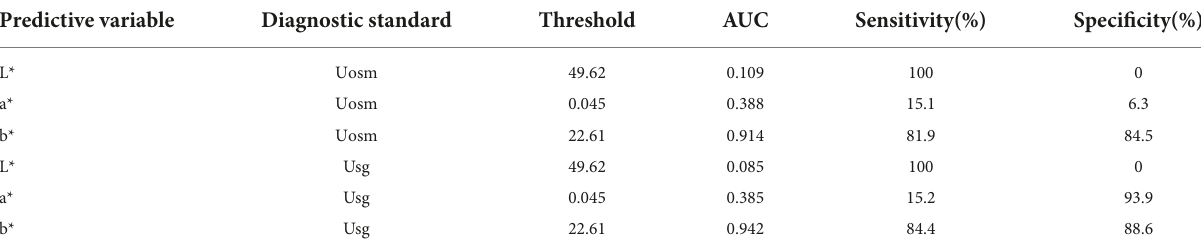
TABLE 2 ROC curve analysis of urine colour L*a*b* to identify hypohydration. Predictive